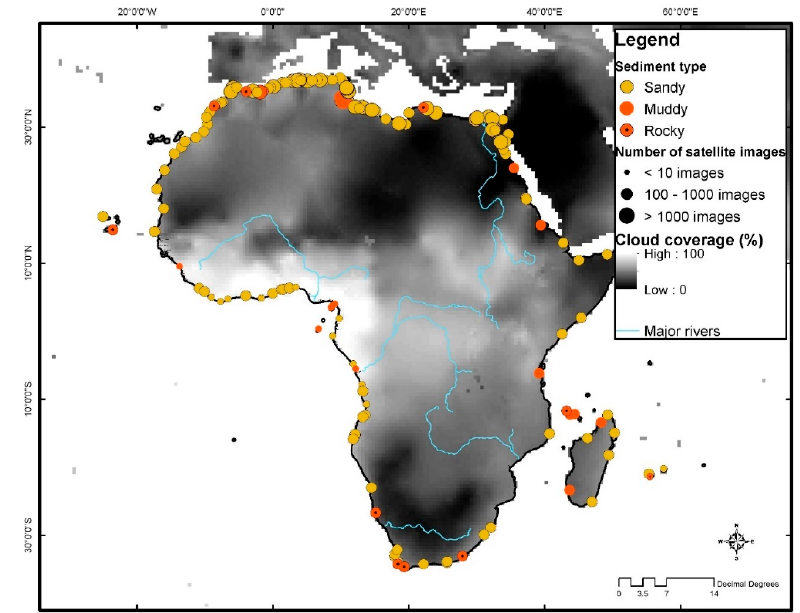
Figure 2. Overview of the African seaports classified in terms of sedimentary characterization of the adjacent coastline. The seaports on sandy coastlines (yellow dots) are included in this study whereas the ports located on muddy (red dots) or rocky (marked red dots) coastlines are excluded. The size of the dots represents the number of available Landsat images in the study timeframe (i.e., 1984–2018). The cloud cover percentage map for 2006 (from [36]), which co-determines image availability, is plotted as reference.